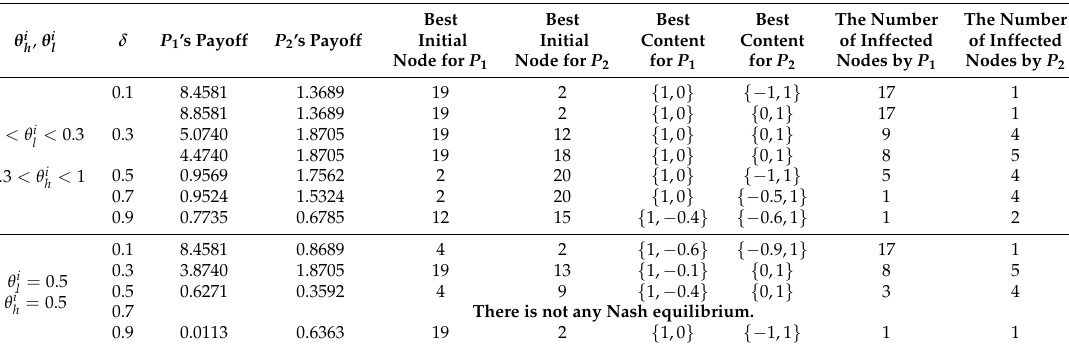
Table 1. Nash equilibrium for a random